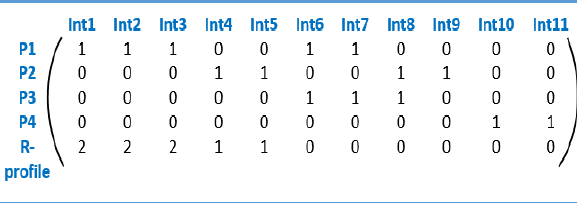
Figure 3. Profiles-Interests Matrix Here are the similarity scores of our approach, the SimRank similarity and the Cosine similarity that each profile obtains with the R-Profile query: